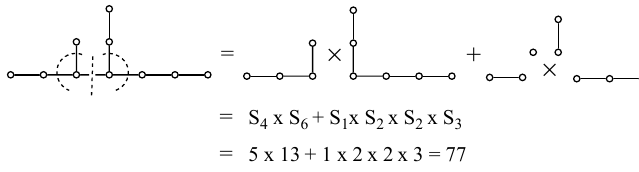
Figure A2. Example of calculating Z of a tree graph with ten vertices.